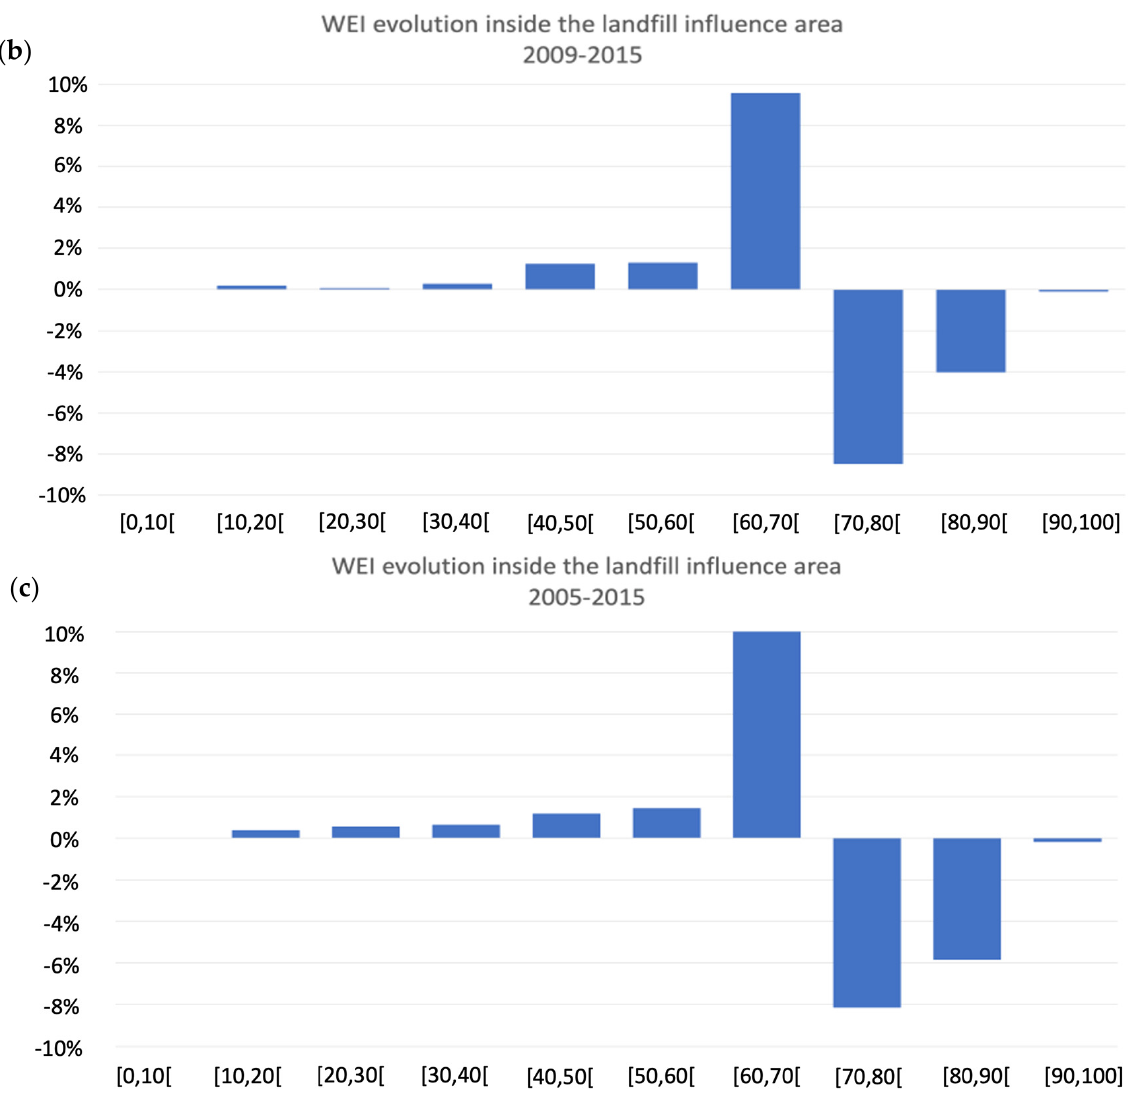
Figure 8. WEI evolution inside the landfill influence area for each one of the ten classes. ( a ) 2005–2009, ( b ) 2009–2015, ( c ) 2005–2015.